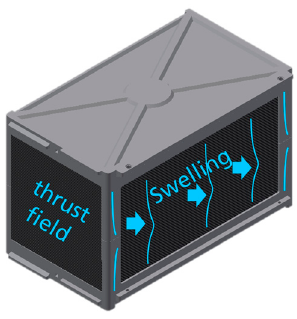
Figure 7. Load case “internal pressure as a result of swelling of the punch cell stack during loading”.